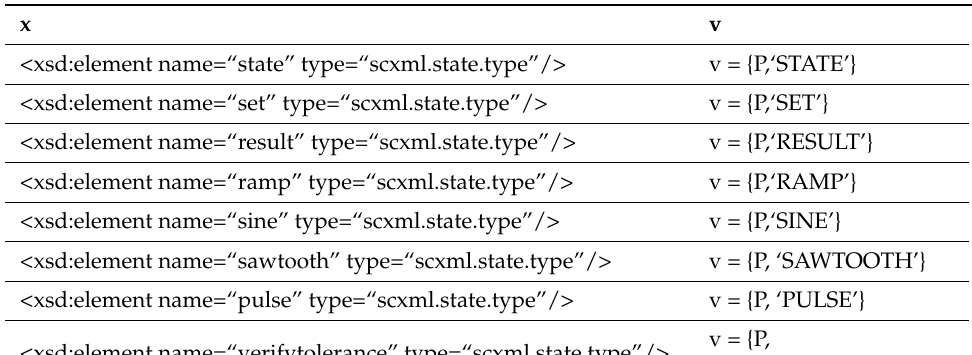
Table 3. Mapping of an SCXML model to Graph